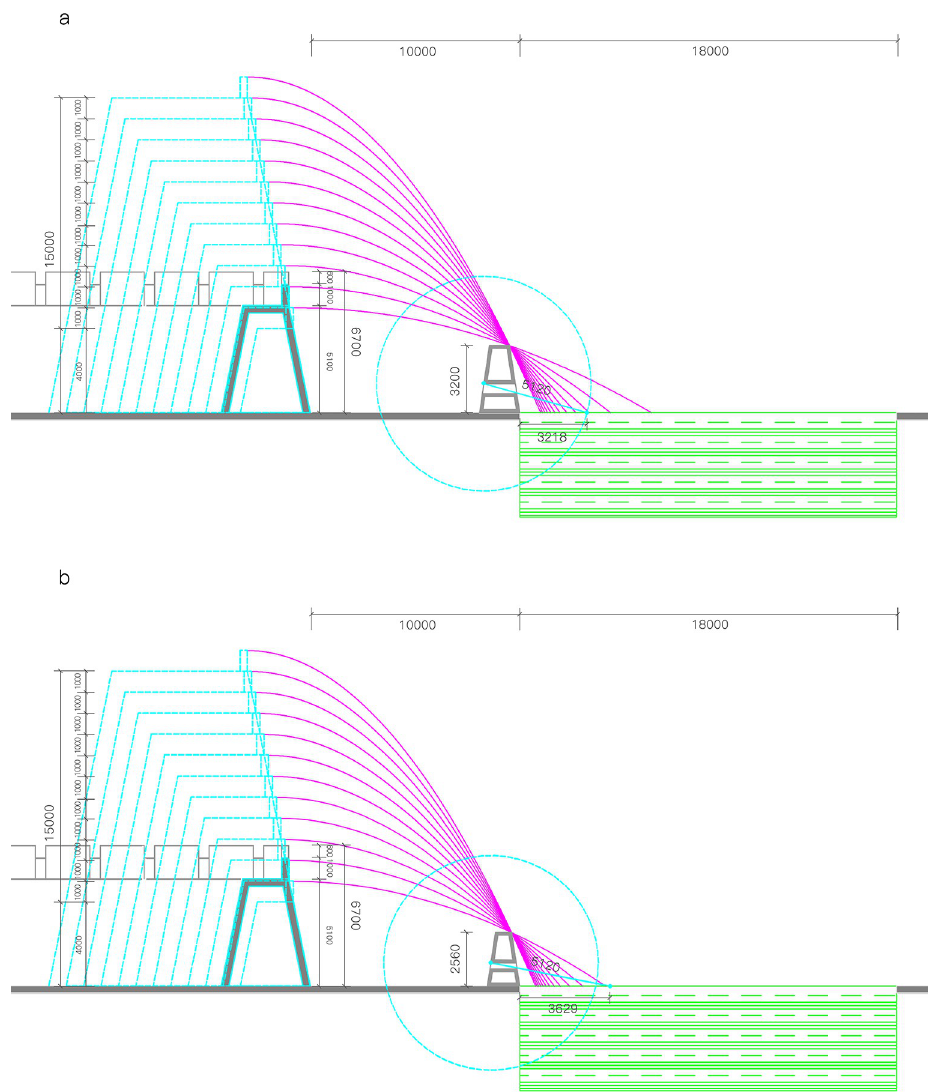
Fig 12. Wall Height and Moat Firepower Coverage model: a—Ten Chi (3.20 m) high Yangmacheng, b—Eight Chi (2.56 m) high Yangmacheng.